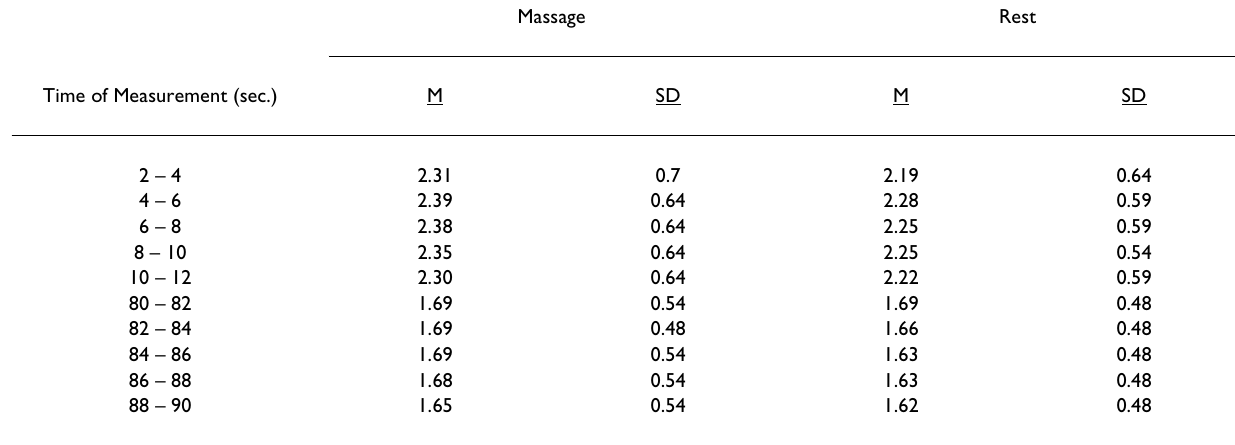
Table 4: Summary of Differences in EMG-Measurement Changes Dependent on Intervention for Squared MNF (N = 29) Massage Rest